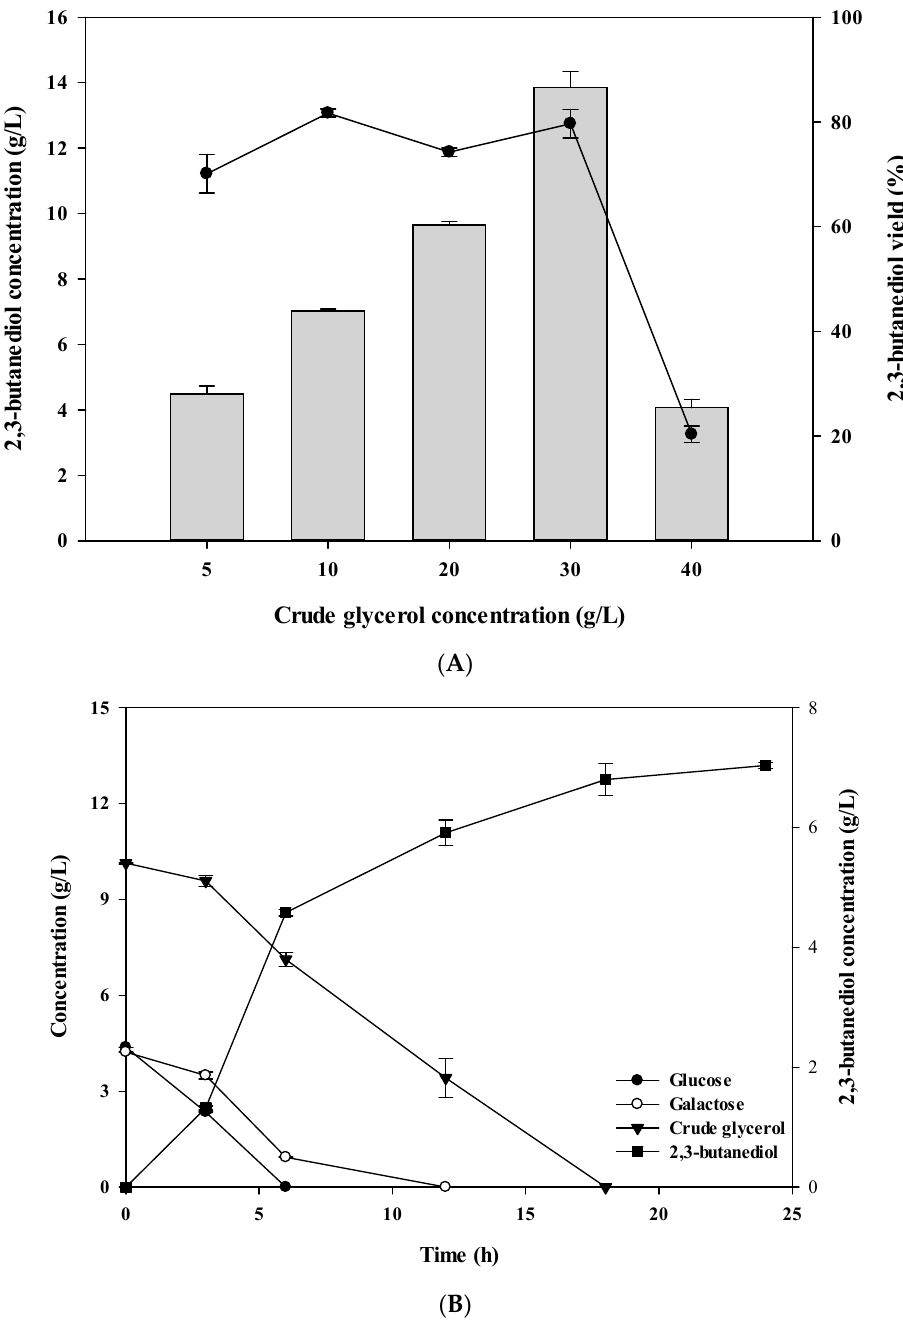
Figure 2. Production of 2,3-BDO from K. aerogenes ATCC 29007 using extracted algal sugars and biodiesel-derived crude glycerol. ( A ) Comparative experiment by crude glycerol concentration and ( B ) 2,3-BDO production using extracted algal sugars and crude glycerol.